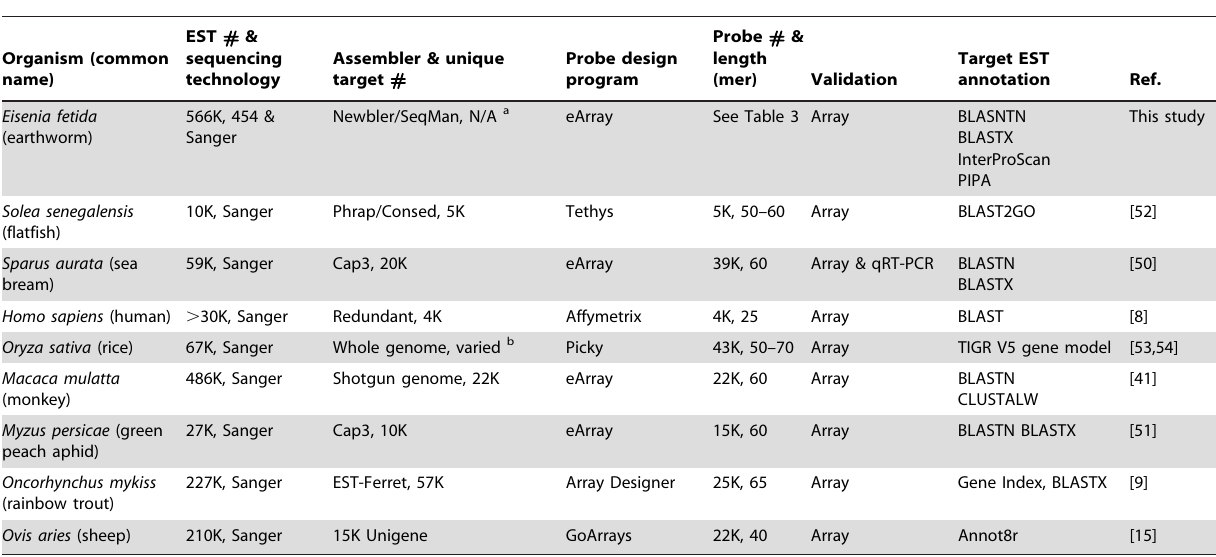
Table 4. Comparison of several representative approaches to transcriptome-scale oligo array probe design, validation and annotation based on species-specific EST sequence